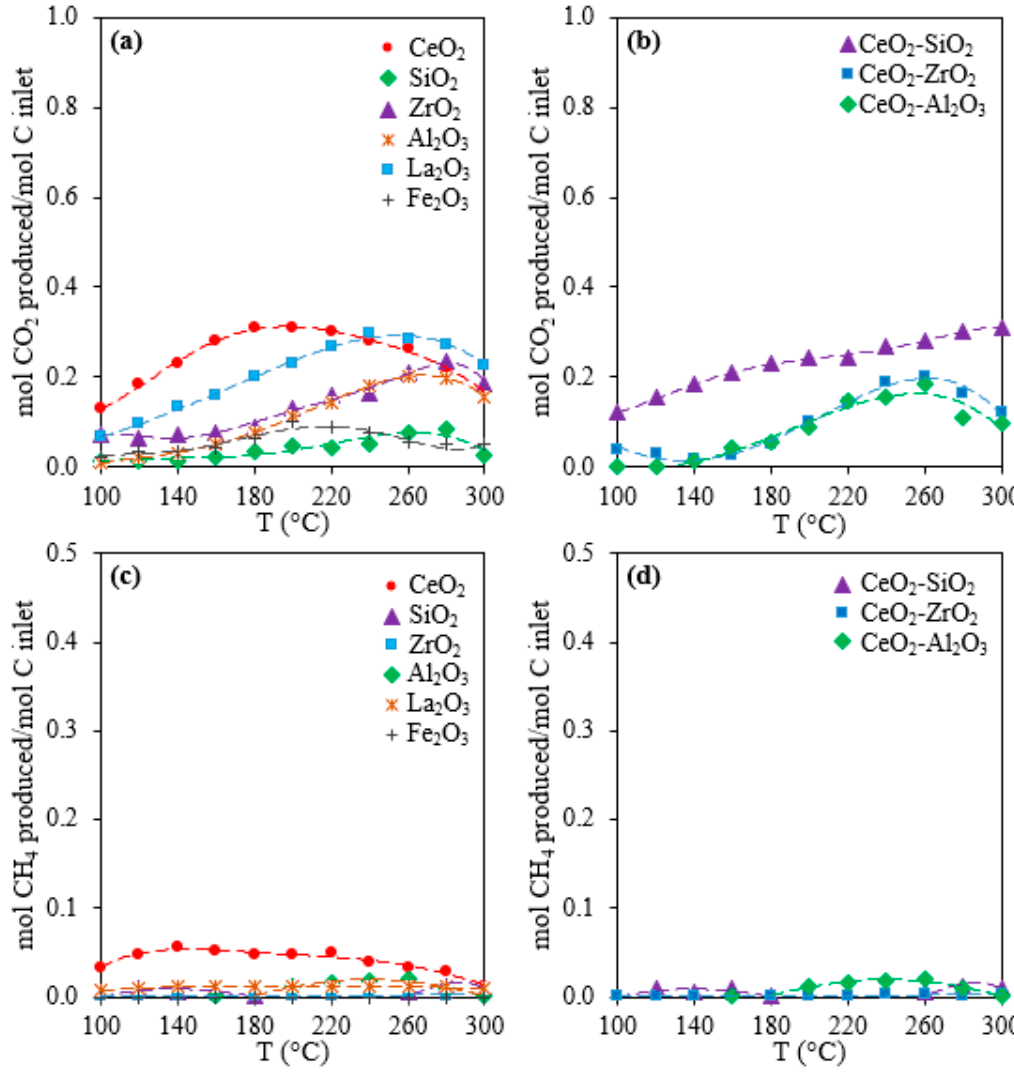
Figure A1. ( a , b ) CO 2 and CH 4 ( c , d ) production in the CO cleanup reactor with simple and dual supports. Syngas composition: 8.4% H 2 , 2.2% CO, 0.6% CO 2 , 0.3% CH 4 , 1.6% H 2 O, and Ar. λ = 1.8. Reaction conditions: SV = 6.5 ± 0.2 L / g cat *min; 0.050 g of catalyst and 0.250 g of inert quartz.